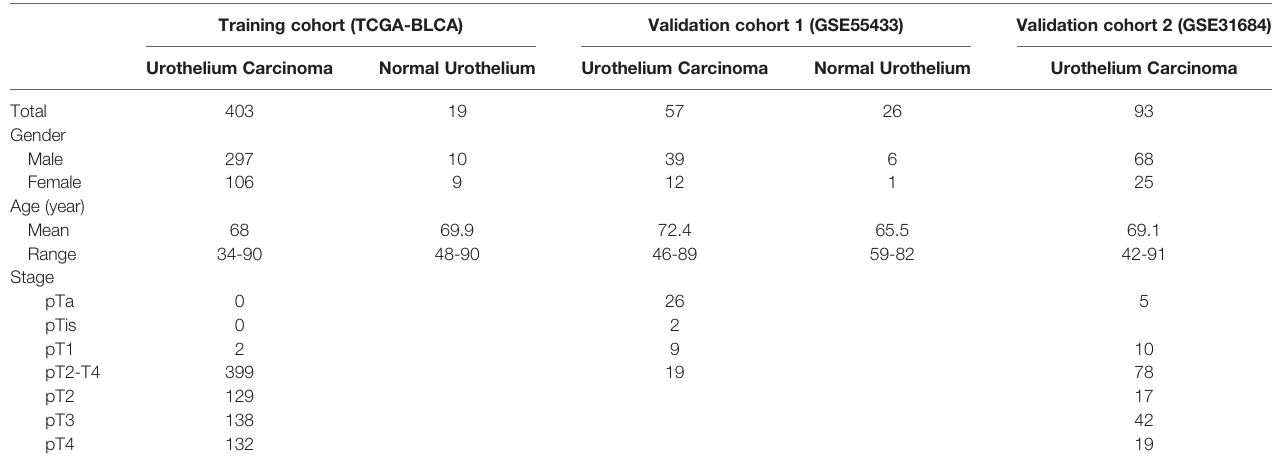
TABLE 1 | Training cohort and validation